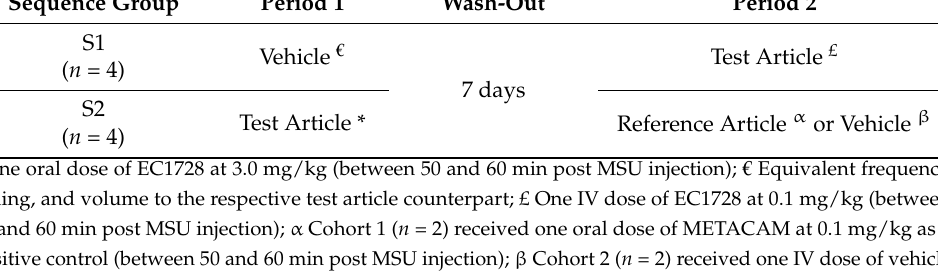
Table 6. Efficacy study design in cats administered monosodium urate and treated with EC1728. Sequence Group Period 1 Wash-Out Period